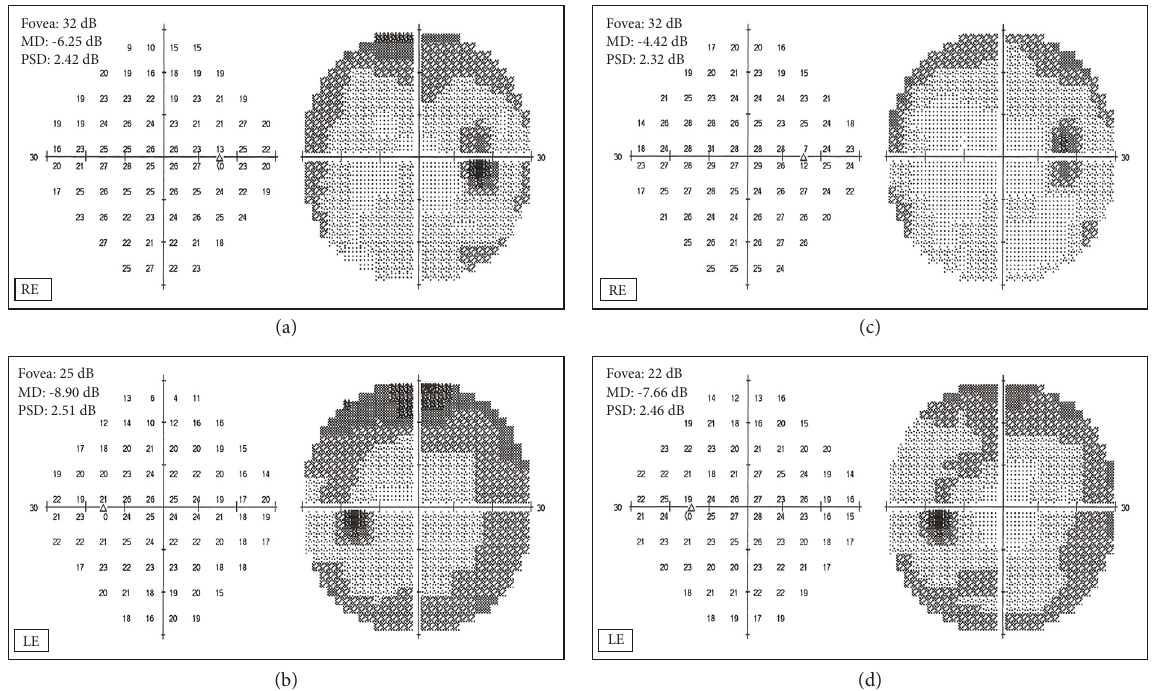
Figure 2: Patient 1. Central 30-2 visual field test recorded in June 2016 (a, b) and September 2016 (c,d), in right (RE) and left (LE)